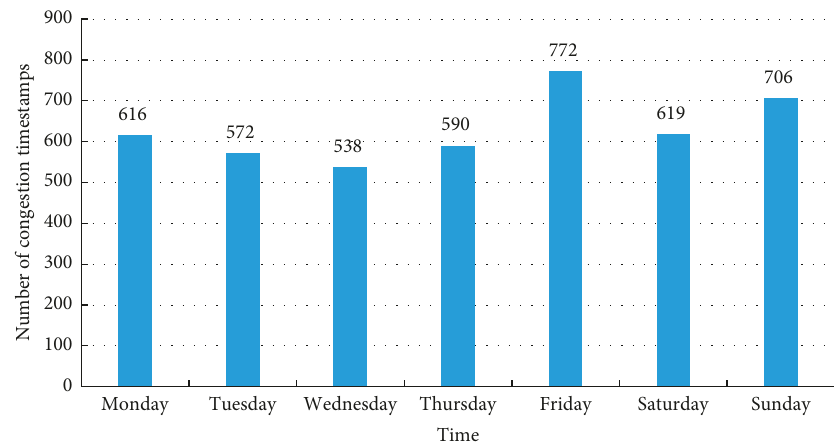
Figure 8: Statistics of the number of congestion time stamps in each day.